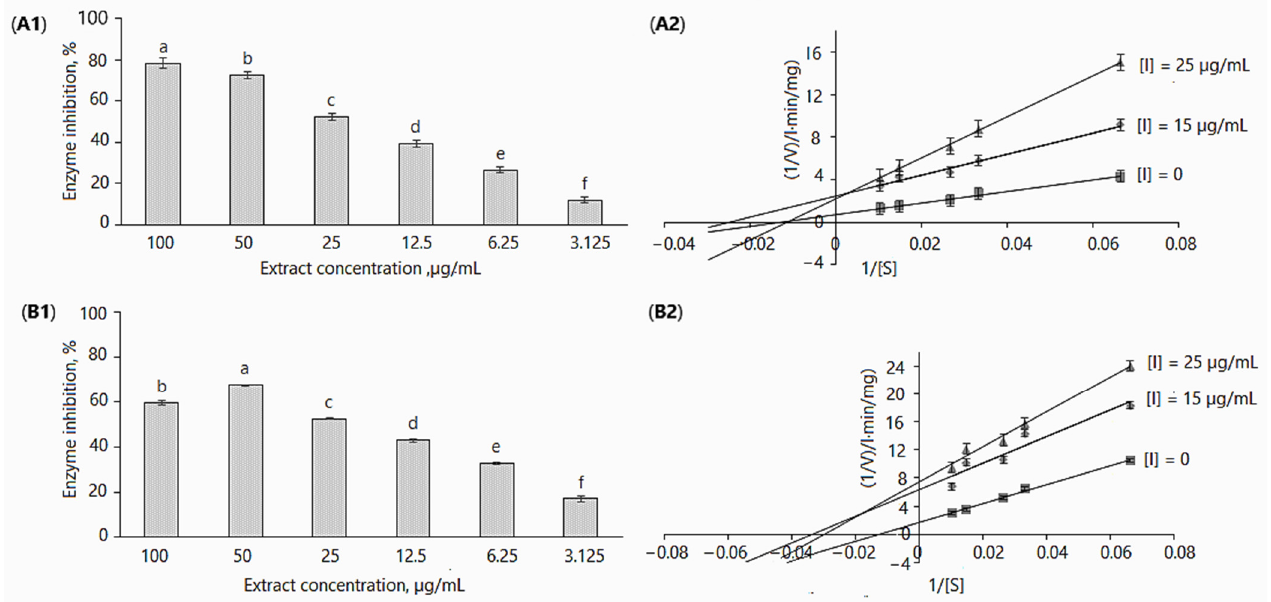
Figure 2. Inhibition of α -glucosidase by D. caucasica 70% ethanol leaf extracts at different concentrations ( A1 , B1 ) and Lineweaver–Burk plot using 0.05–0.33 mM of p NPG ( A2 , B2 ): ( A1 , A2 ) without adding 0.1 M Na 2 CO 3 ; ( B1 , B2 ) with adding 0.1 M Na 2 CO 3 . The values are the means ± standard deviation SD ( n = 3). Different letters in ( A1 , B1 ) indicate that the values are significantly different, according to Fisher’s LSD test ( p < 0.05) after one-way ANOVA. Table 2. Effect of D. caucasica 70% ethanol extract of leaves on the percentage inhibition of α - glucosidase enzymatic